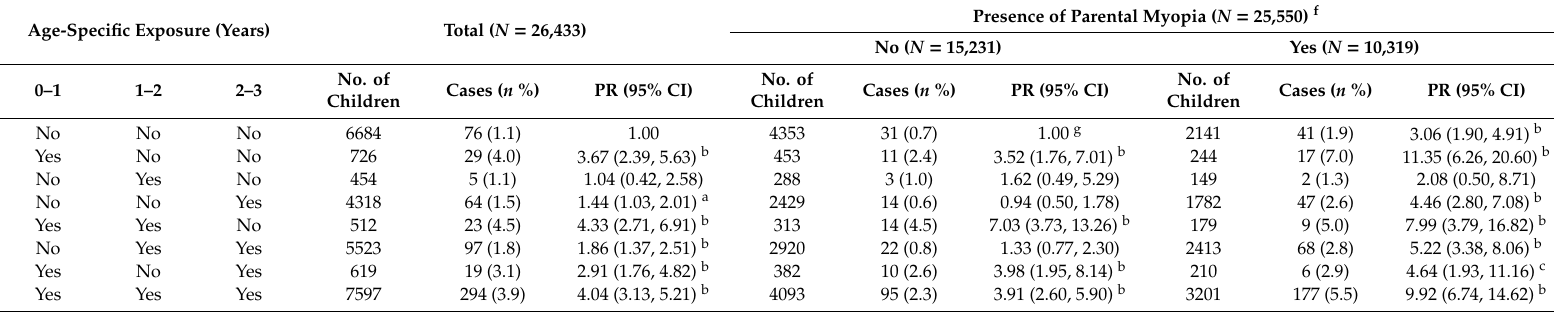
Table 4. Associations between screen exposure during the early stage of life (postnatal three years) and preschool myopia e . Age-Specific Exposure